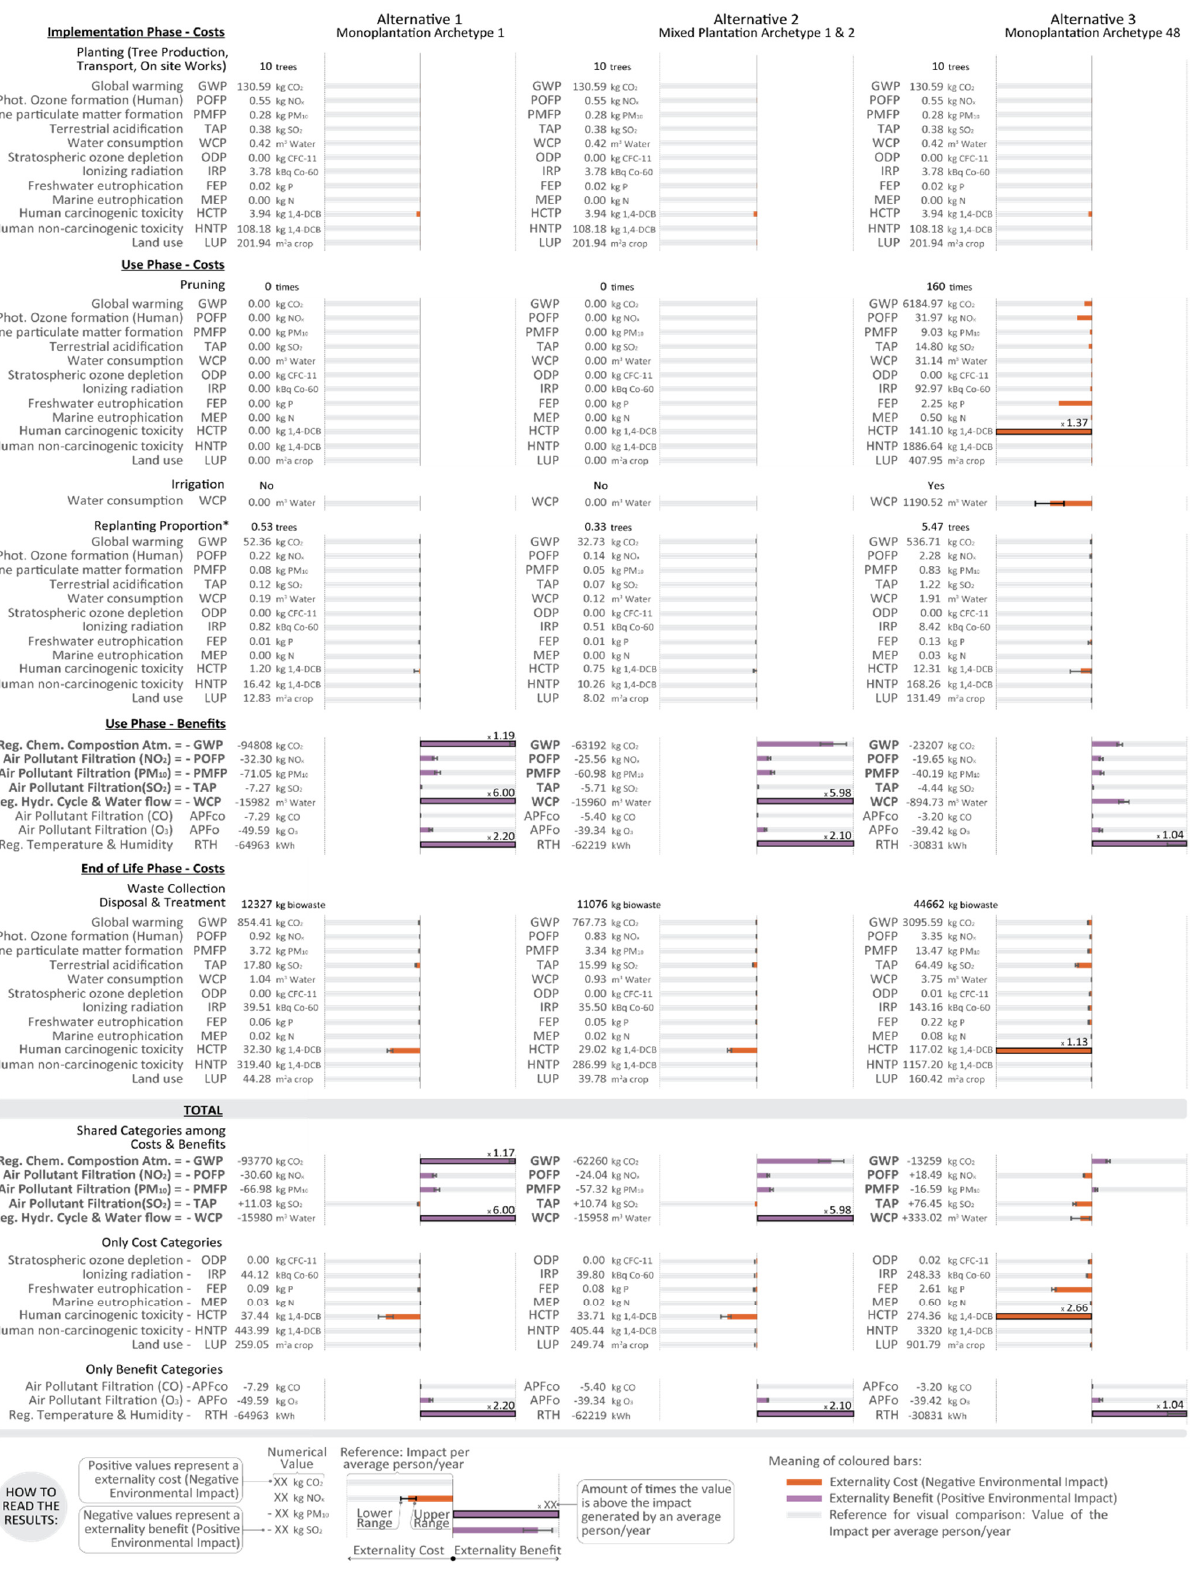
Figure 15. Comparison of benefits (positive externalities) and costs (financial and negative externalities) in biophysical units per life cycle phase and in total. Costs are represented in orange and benefits in purple.